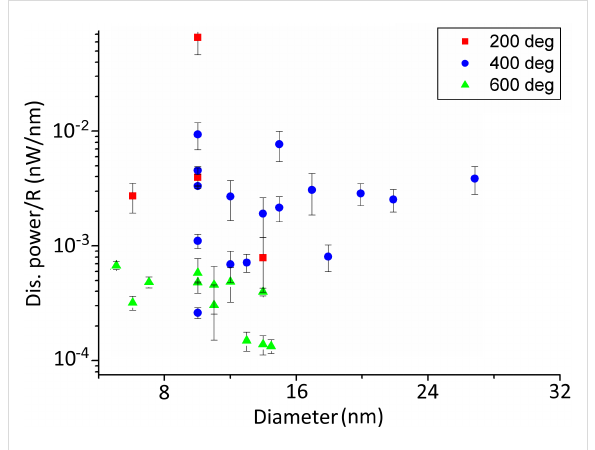
Figure 6: Dissipated power per NP radius as a function of the NP di- ameter. The diameter is defined as the height of the NP in the AFM